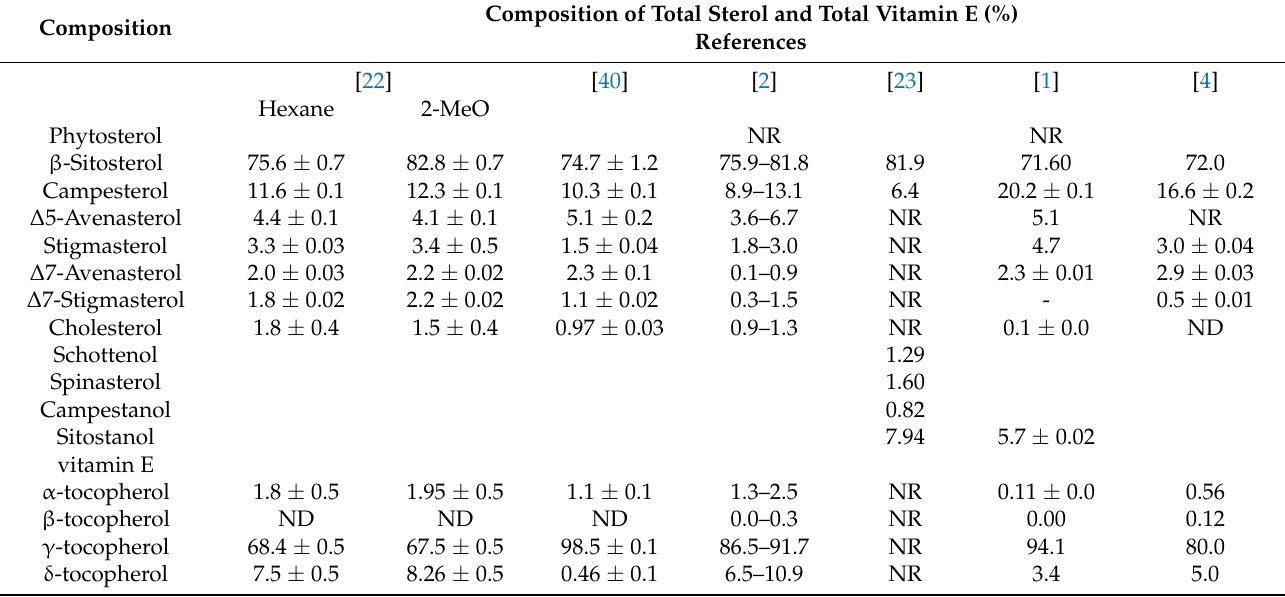
Table 4. Composition of phytosterols and vitamin E (%) of prickly pear seed oil. Composition of Total Sterol and Total Vitamin E Composition